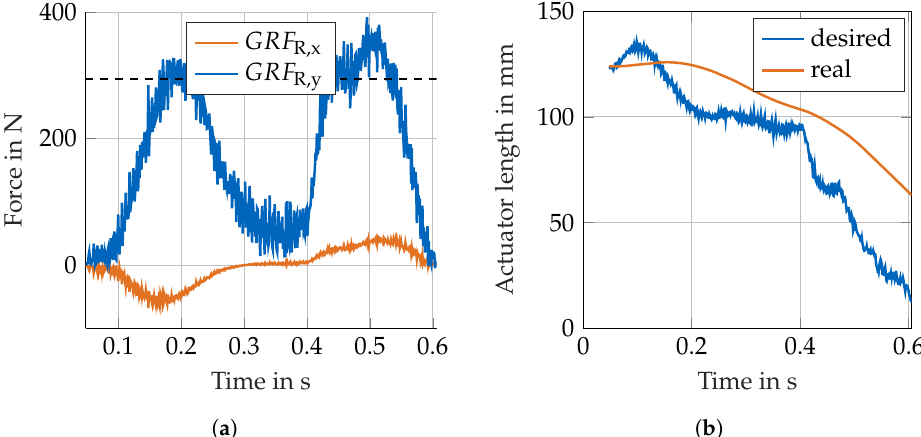
Figure 9. Measurement data during the HiL test. ( a ) The GRFs in the x and y direction during the stance phase of the right leg. The black dashed line indicates the body weight. ( b ) The desired and real displacement of the Stewart Platform’s Leg 1 are shown. Leg 1 undergoes the largest motion command of all six legs.